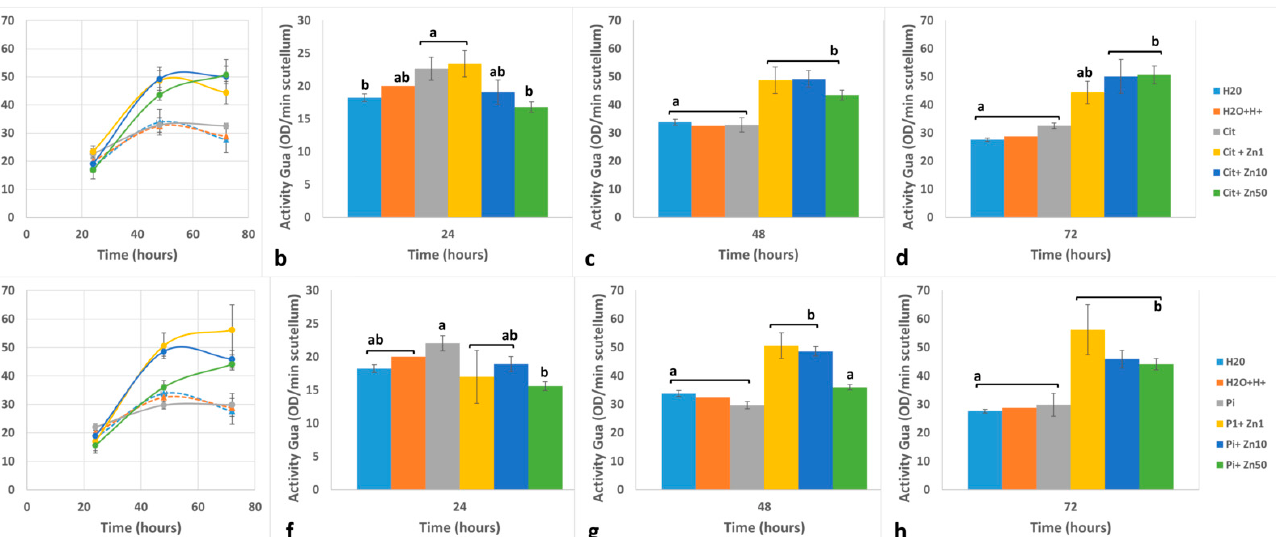
Figure 4. Effects of zinc on the activity of Peroxidase quantified with catechin + H 2 O 2 as substrates (POD-Cat) from maize scutellum. Embryos were imbibed for 24 to 72 h in H 2 O, H 2 O+H + , Cit, Cit+Zn1, Cit+Zn10, Cit+Zn50, Pi, Pi+Zn1, Pi+Zn10, or Pi+Zn50. Activity was determined using catechin + H 2 O 2 as substrates in ( a ): Cit or ( e ): Pi. Imbibition times were ( b , f ): 24 h; ( c , g ): 48 h; and ( d , h ): 72 h, in Cit or Pi, respectively. The data represent the mean ± SE of n = 3 to 6 independent assays. ANOVA was performed, followed by the Tukey–Kramer multiple comparison test, with p < 0.05 representing significance. Letters that are the same indicate similar variations, and the different letters indicate significant changes at each imbibition time.